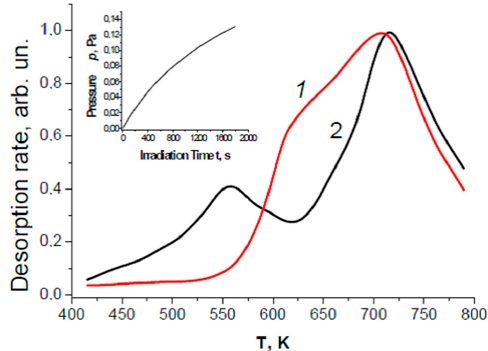
Figure 2. TPD spectra of molecular oxygen for powdered KBr: (1) after photolysis of adsorbed water (curve 1 ); and (2) after photoadsorption of oxygen (curve 2 ). In all cases, irradiation of the samples was performed with a high pressure Hg lamp (DRK-120) whose incident photon irradiance was 5 × 10 14 photon·cm ‒ 2 ·s ‒ 1 at λ ≤ 250 nm; irradiation time for water photolysis was 2000 s; the amount of photolytic and chemisorbed oxygen was nearly 2 × 10 15 molecules; volume of reactor was ca. 100 cm 3 ; front illuminating area of the reaction cell was ~5 cm 2 . Insert shows the kinetics of H 2 evolution in the gas phase during water